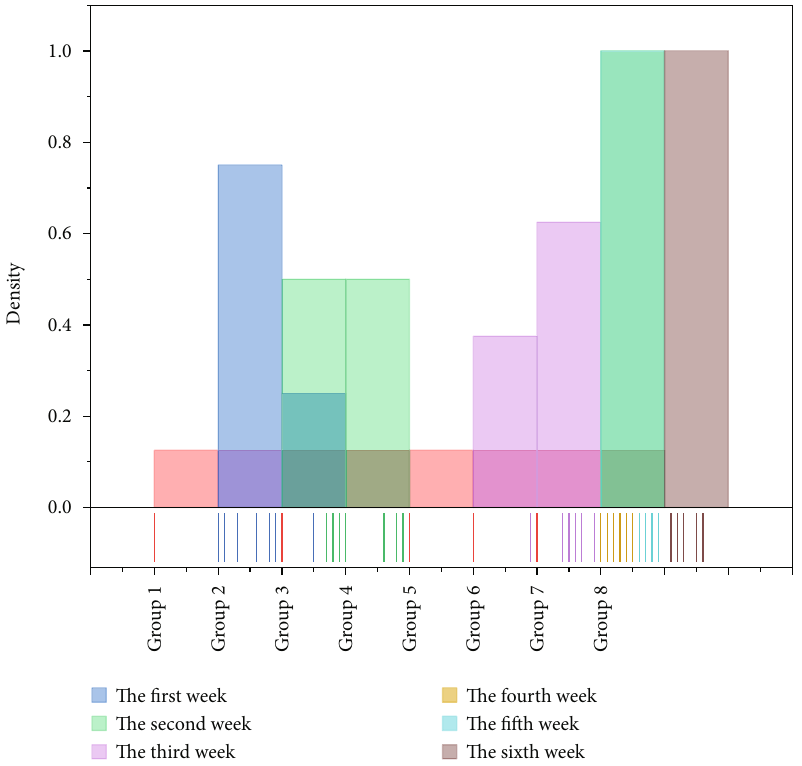
Figure 7: The change curve of pronunciation standard of students in each